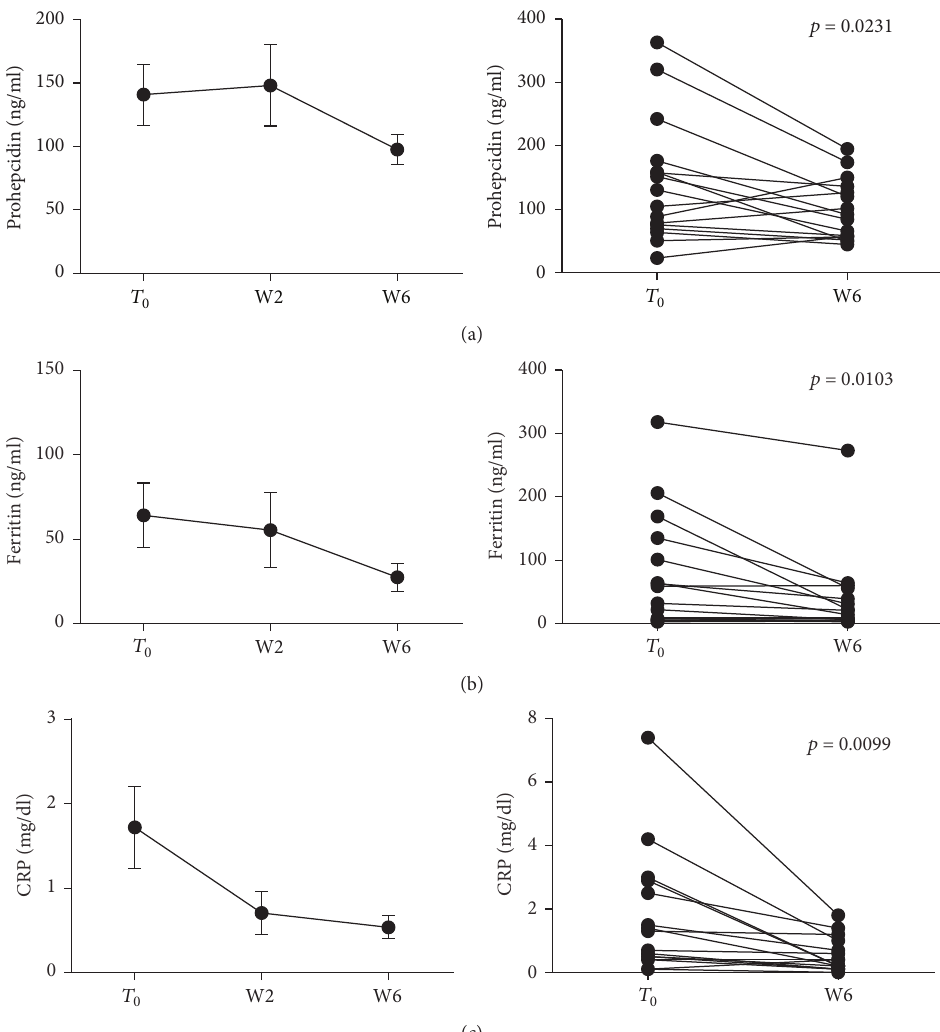
Figure 3: Prohepcidin and acute phase protein levels during anti-TNF therapy in CD patients. Blood samples were collected before each anti- TNF administration and parameters measured. Statistical analysis was performed using Student’s 𝑡 -test for paired data. Data are presented as single data point or as mean ±